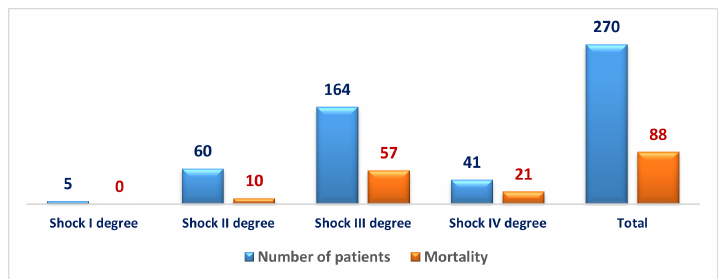
Figure 9. Dependence of the mortality rate on the degree of shock in the main group, n =